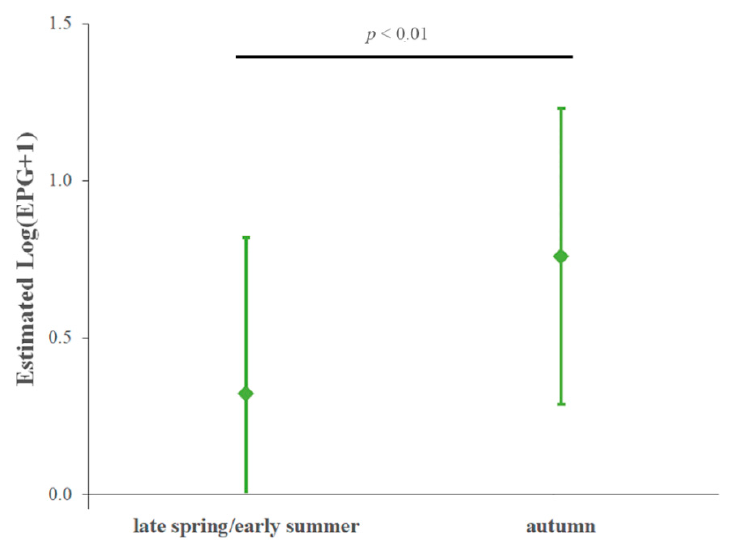
Figure 1. Estimated nematode Log(EPG+1), by time of sampling, in herbivores housed in the studied faunistic park obtained by a generalized linear mixed model. Vertical bars: 95% confidence intervals; horizontal black bar: pairwise comparison between nematode eggs excretion in the two sampling points.